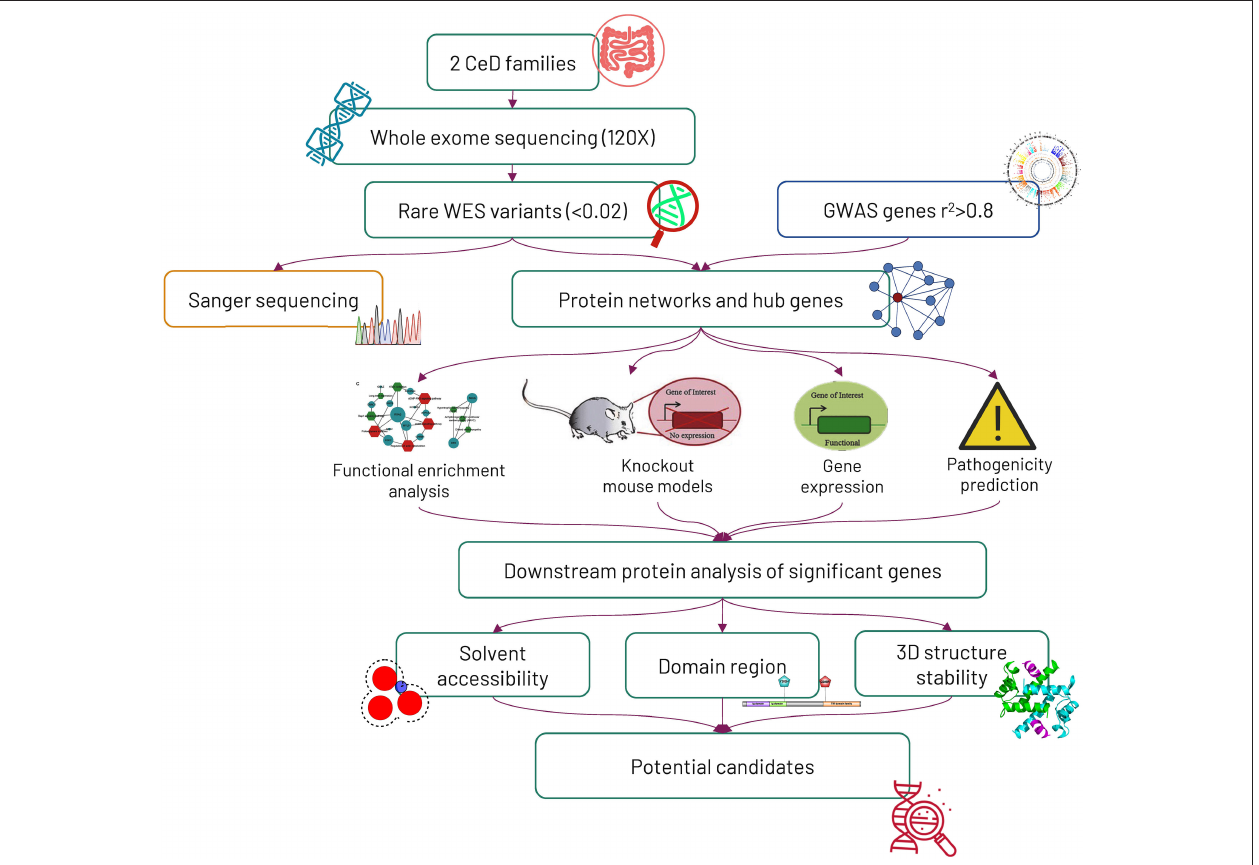
FIGURE 1 | Workflow of the study. Initially, 2 Saudi celiac families were exome sequenced, and later, the mode of variant segregation in the families was determined by the Sanger sequencing method. The rare variants identified from whole-exome sequencing were mapped against genome-wide association study (GWAS) genes, and then the potential hub genes identified from the protein networking were further characterized by computational functional